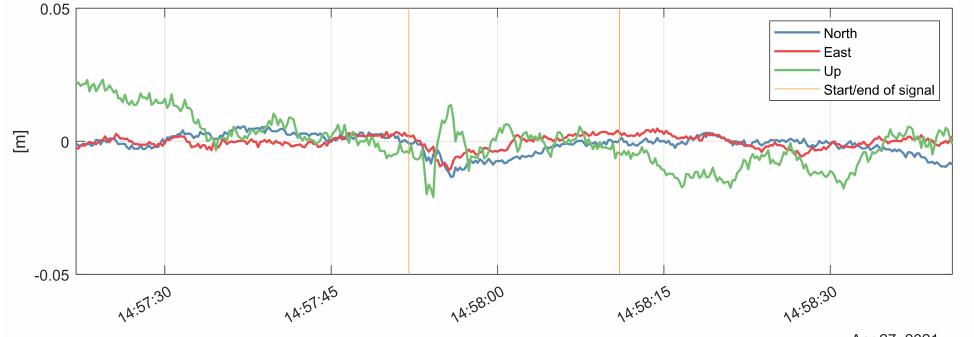
Figure 10. Session 1: residuals of the dynamic tests (u-blox) computed as “GNSS NEU coordinates minus robot NEU coordinates”.